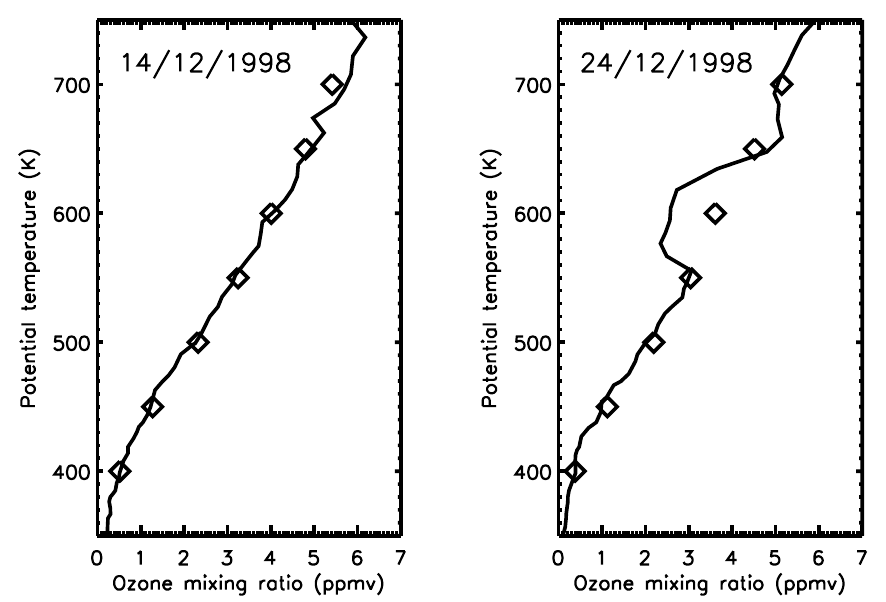
Fig. 4. Lauder ozonesonde (full line) and POAM ozone (diamonds) comparison for seven isentropic surfaces (400–700K) on 14 and 24 December